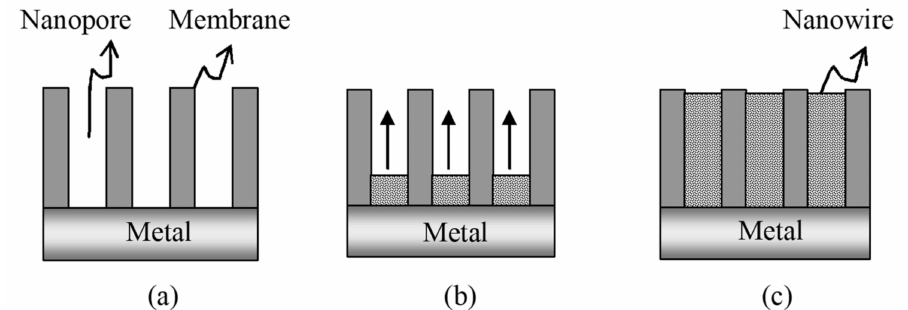
Figure 9. ( a ) Nanoporous membrane that has one side coated with a metallic film. ( b ) Electrochemical deposition through the nanopores (the arrows indicate the growth direction of nanowires inside pores). ( c ) Nanowires obtained inside nanoporous